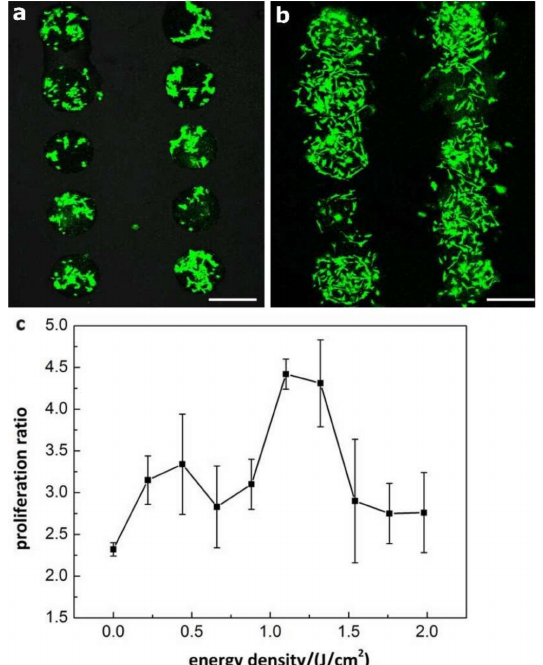
Figure 8. The proliferation condition of the green fluorescent protein (GFP) labeled mouse mesenchymal stem cells (MSC) on array of graphene oxide thin film on Cytop. ( a ) Confocal microscope image of the stem cells adhering to and growing on only graphene oxide thin film after washing with phosphate-buffered saline (PBS) buffer. ( b ) Confocal microscope image of the stem cells after irradiation with low-level laser light and culture for 24 h. ( c ) The relationship between the stem cell proliferation ratio and the energy density of the low-level laser light. The proliferation ratio was the average of three parallel measurements. The confocal microscope images for each irradiation energies are available as Figures S2–S11 in Supplementary Materials. Scale bars: 500 µ